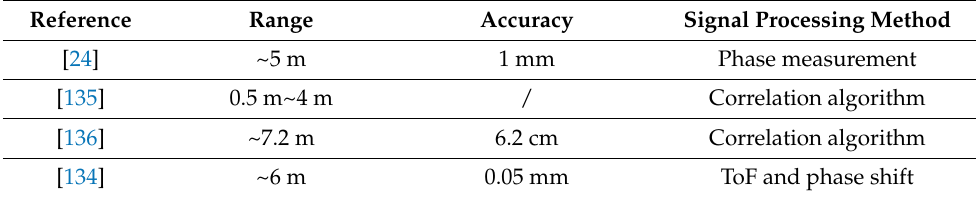
Correlation algorithm Correlation